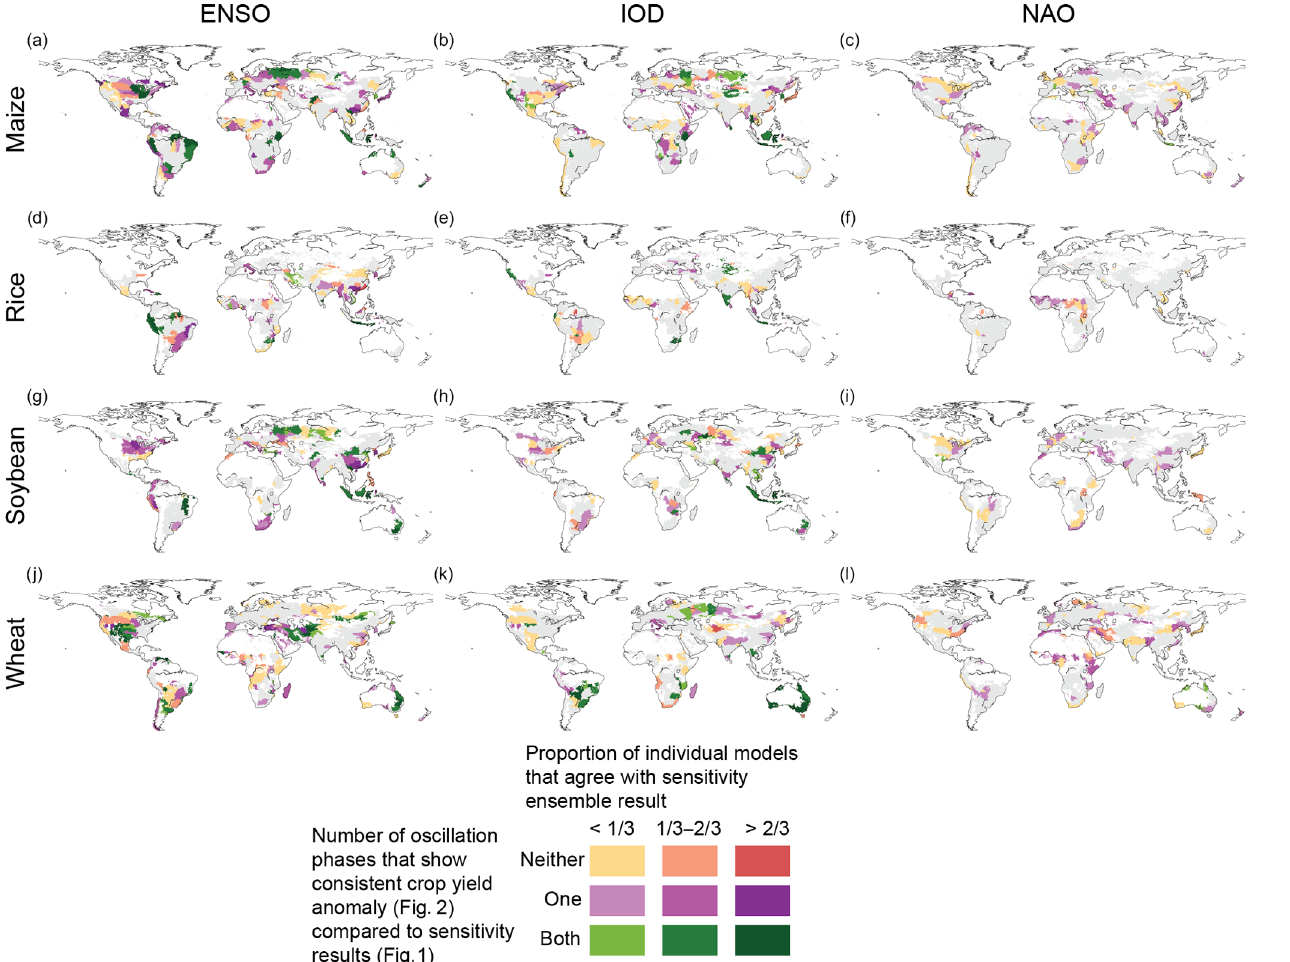
Figure 3. Summary of the relationship between ENSO, IOD, and NAO and crop yields across models and methods for maize (a–c) , rice (d–f) , soybean (g–i) , and wheat (j–l) . The y axis of the colour bar shows whether there is agreement between the sensitivity analysis (Fig. 1) and the average anomalies during strong oscillation phases (Fig. 2): “neither” denotes that the strong oscillation phases are not related to significant average crop yield anomalies that are consistent with the sensitivity analysis; “one” means that either the positive or negative oscillation phase shows a significant average anomaly that is consistent with the sensitivity result (e.g. positive sensitivity and positive anomaly during a positive oscillation phase); and “both” means that both phases of the oscillations show consistent average anomalies during the strong oscillation phases (e.g. positive anomaly during a positive oscillation phase and negative anomaly during a negative oscillation phase in an FPU with positive sensitivity). The x axis of the colour bar shows the proportion of individual models that show significant sensitivity of the same sign compared to the result from the ensemble analysis (see Fig. 1 above, Fig. S10, and zip files in the Supplement). Areas where the ensemble results do not show a statistically significant relationship are marked in grey, while white denotes that the crop in question is not grown in that